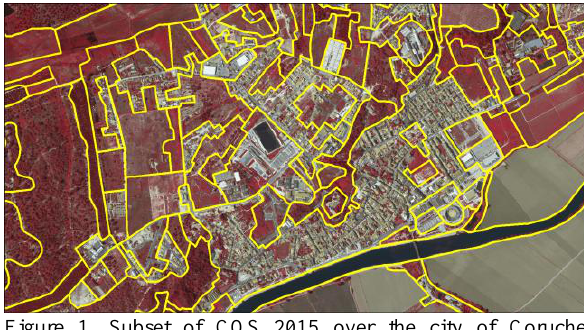
Figure 1. Subset of COS 2015 over the city of Coruche (38°57'30,05"N; 8°31'36,013"W). Background: false colour orthophoto of